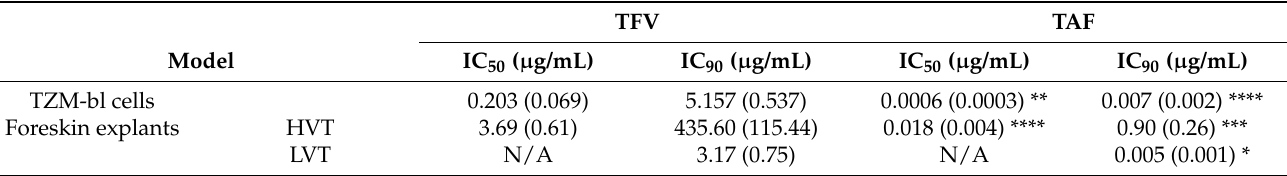
Figure 4. Inhibitory potency of TFV and TAF. ( a ) TZM-bl cells and ( b , c ) foreskin explants from • HIV-negative donors were dosed with TFV ( , ) or TAF ( (cid:4) , (cid:3) ) 1 h prior to challenge with HIV-1 BaL (cid:35) at a normalized titer for TZM-bl cells or at a HVT (solid symbols) or LVT (open symbols) for tissue explants. Percentage of inhibition was normalized relative to the r.l.u. or p24 values obtained for cells or explants not exposed to virus (0% infectivity) and for cells or explants infected with virus in the absence of compounds (100% infectivity), respectively. Inhibitory activity equivalency was established in tissue explants (dotted lines and grey band in ( c )). Data are the means (SEMs) from independent experiments performed in triplicate with specimens from three donors. Table 1. Inhibitory potency of tenofovir (TFV) and tenofovir alafenamide (TAF) against HIV-1 BaL